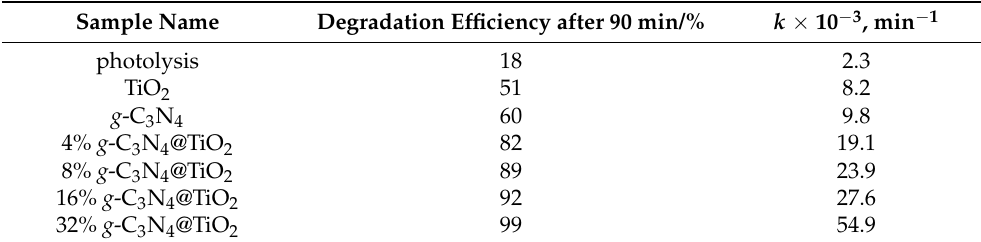
Table 3. The values of degradation efficiency of MB under simulated solar irradiation and first- order rate constant ( k ).